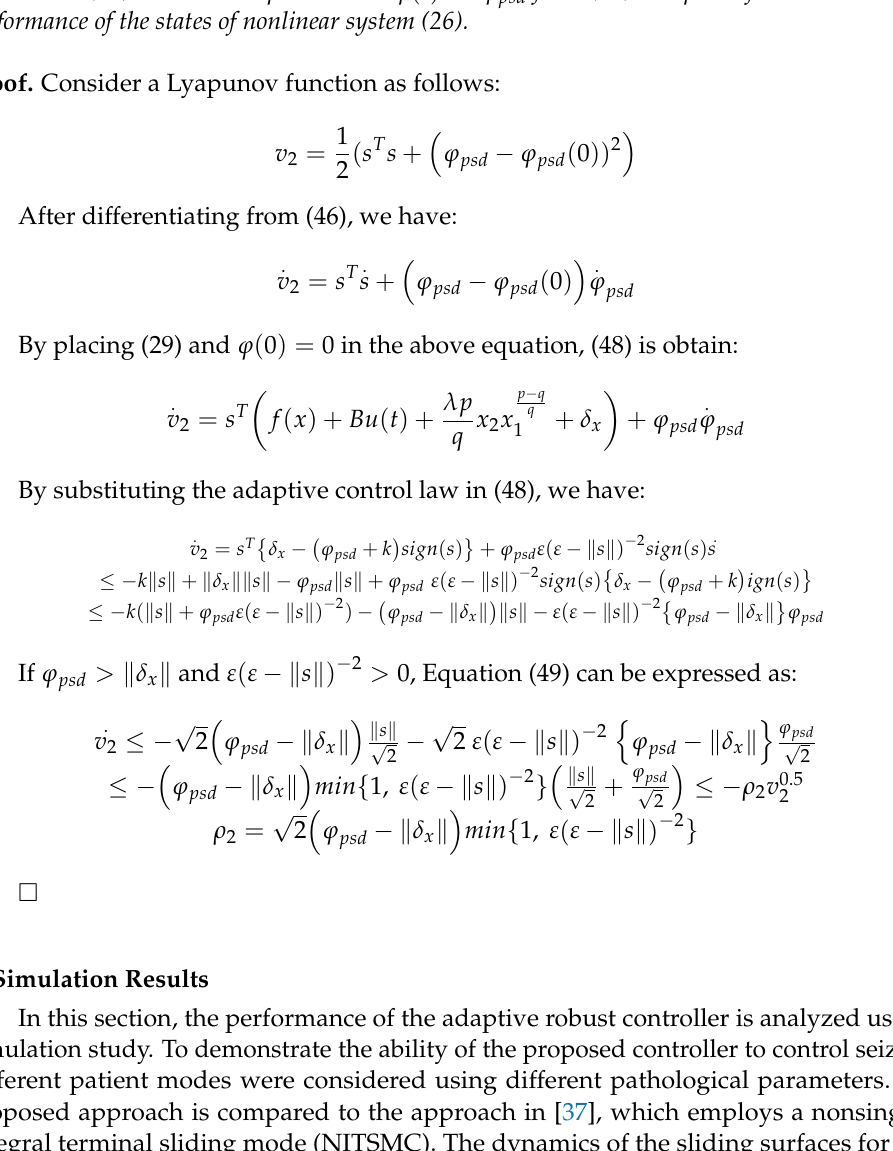
Figure 7. Comparison between ABTSMC and NITSMC control signals. As shown in Figure 8, 𝑉 𝑠 is the epileptic state after applying the ABTSM controller in the presence of disturbance and uncertainty, tracking the healthy state well. The pro- posed approach performance is compared with the approach proposed in [37]. The track- ing error in the ABTSMC technique is less. Figure 8. Tracking the healthy state of soma potential by ABTSM and NITSMC. Mean square error (MSE), IAE and ISV criteria are examined in Table 2 and confirm the performance of the proposed method. The error of the proposed method is very small and close to zero. The error waveform after applying ABTSMC and NITSMC is shown in Figure 9.